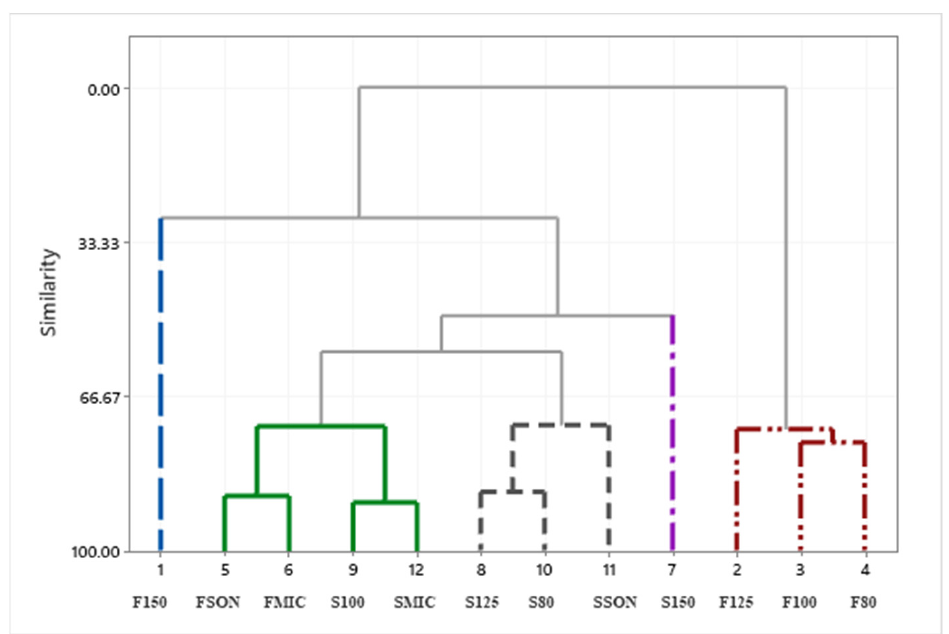
Figure 3. Loading plot.